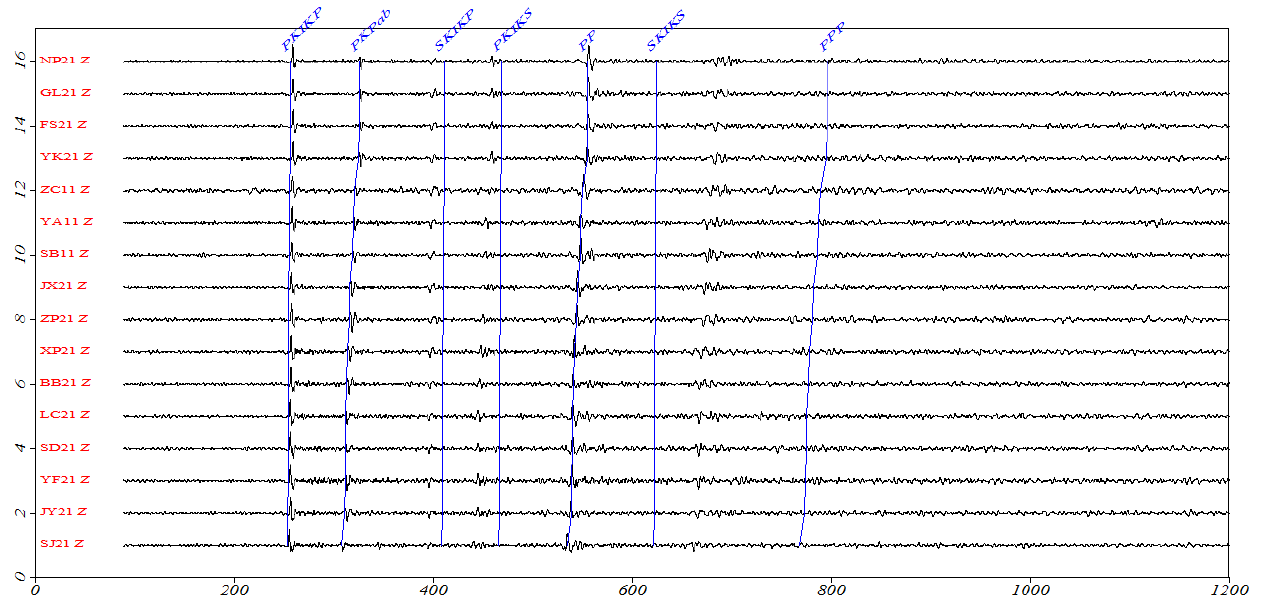
Figure 6. Brazilian earthquake records and theoretical arrival times of PKIKP, PKPab, SKIKP, PKIKS, PP, SKIKS, and PPP seismic phases.